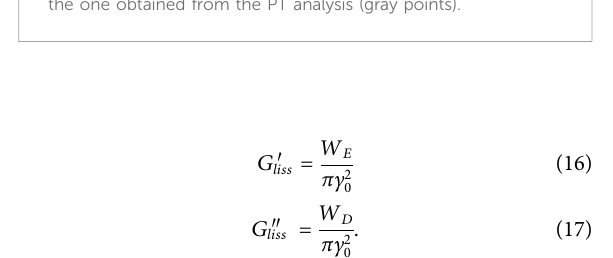
FIGURE 9 Microscopic, shear-induced dynamics of tracers embedded in Carbopol 5%shared at ω = 2 π rad/s with strain amplitudes 24.5% (blue),105%(purple)and188%(red). (A) meansquaredisplacement obtained from echo particle tracking analysis in the vorticity direction.Graydashedlinesarebest fi twith fi ttingfunctionMSD v = Δ t . In the inset, we plot the diffusivity obtained from the σ MSD + 2 D v fi t as a function of the measured strain. (B) Relaxation rate from echo-DDM analysis of the same experiments. Green dashed lines are best fi tting curves with the function Γ = D v q 2 . Gray shaded area identi fi es the region where fi ts are not reliable. In the inset, the diffusivity obtained from the fi t (colored points) is compared with the one obtained from the PT analysis (gray